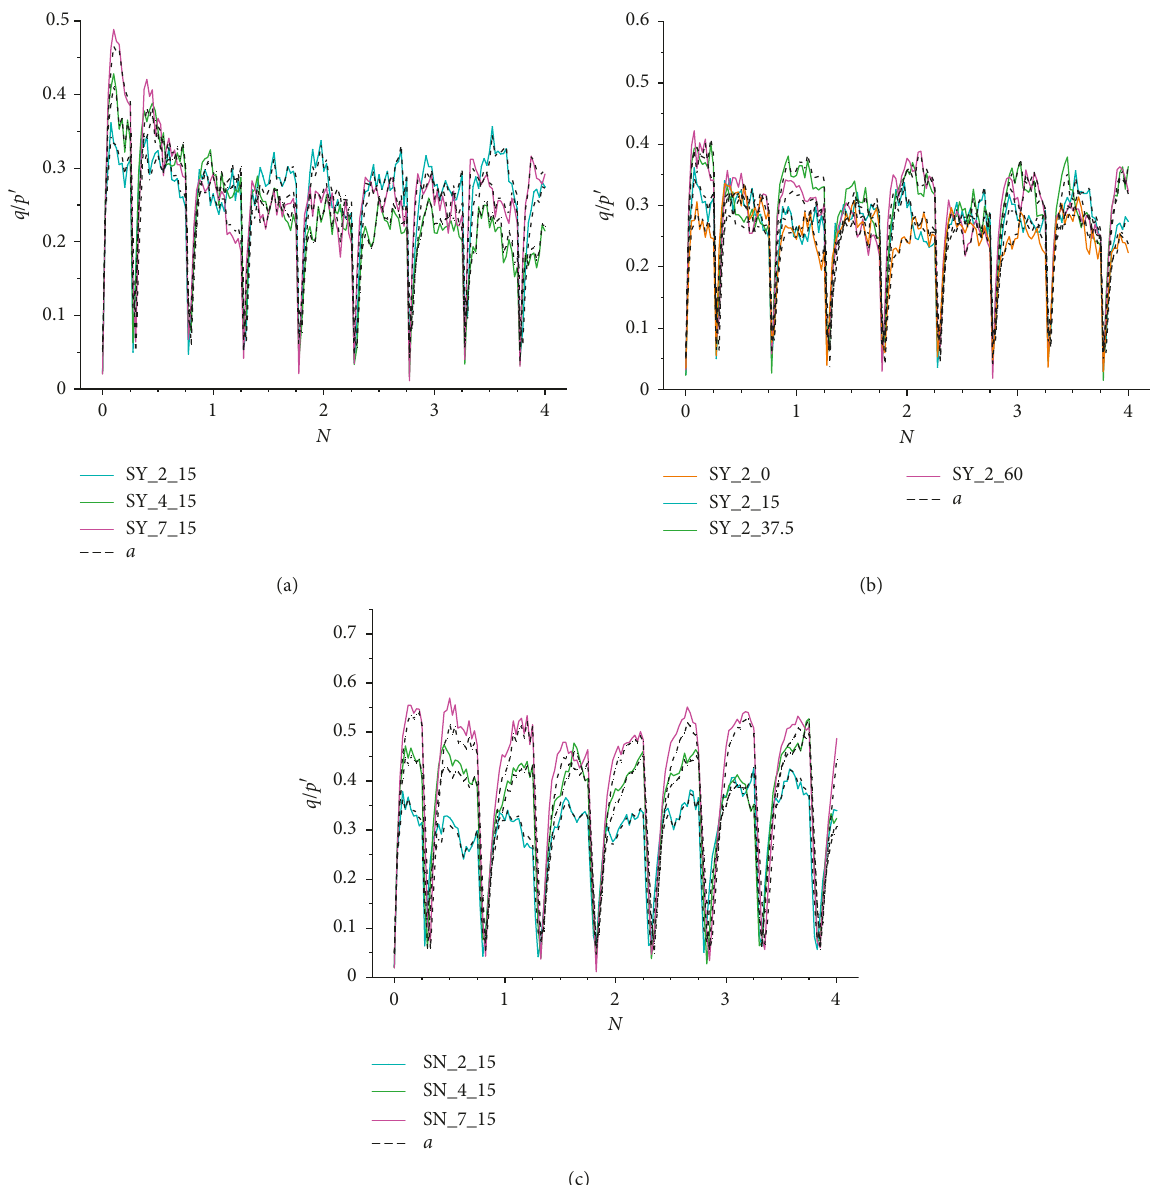
Figure 19: Evolution of q / p ′ : (a) reference group; (b) composite pattern group; (c) unbreakable